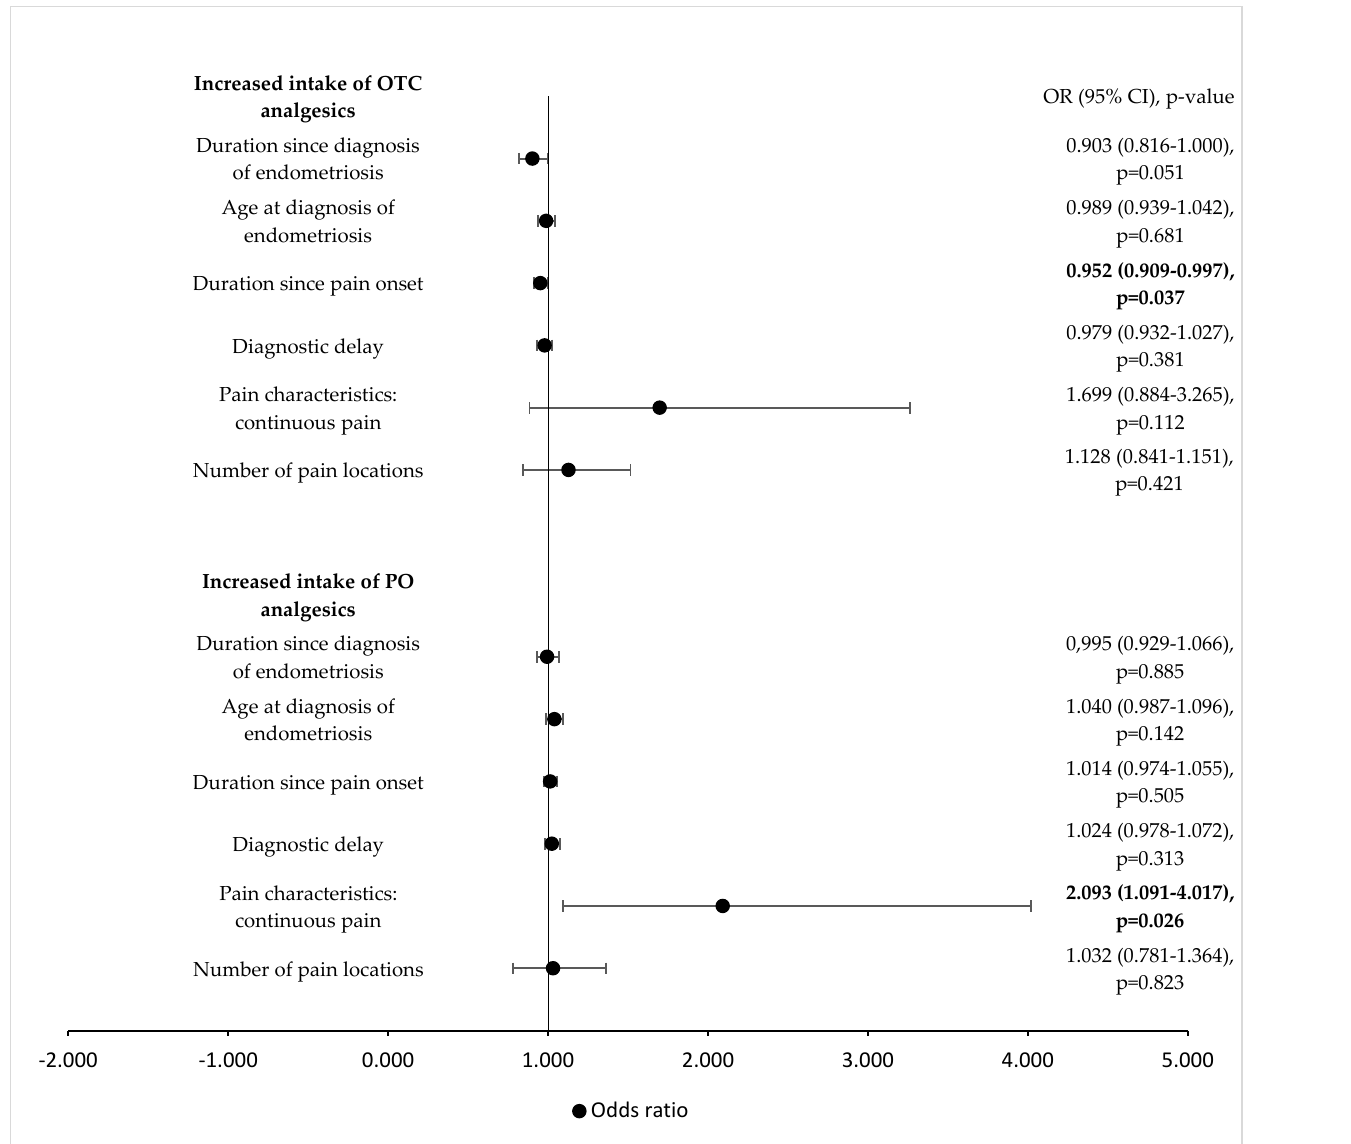
Figure 1. Influence of endometriosis ‐ specific factors on increased analgesic intake (univariate logistic regression analysis). OTC = over the counter; PO = prescription only; OR = odds ratio; CI = confidence interval. Values in bold indicate statistical significance, as the level of statistical significance was set to p < 0.05.